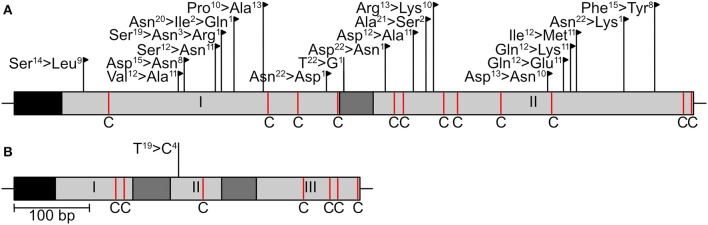
Sequence variation in candidate effector genes of Exserohilum turcicum. The sequences of two candidate effectors (A
SIX13-like, B
SIX5-like) were determined in 23 E. turcicum isolates from maize and sorghum. Black boxes indicate signal peptides, light gray blocks represent exons, and introns are shown as dark gray blocks. Cysteine residues are indicated as red lines with a “C.” Nucleotide substitutions that resulted in non-synonymous amino acid changes are indicated by black flags, while substitutions resulting in synonymous changes are indicated by black lines. The number of isolates representing each amino acid/nucleotide is given as a superscript number.